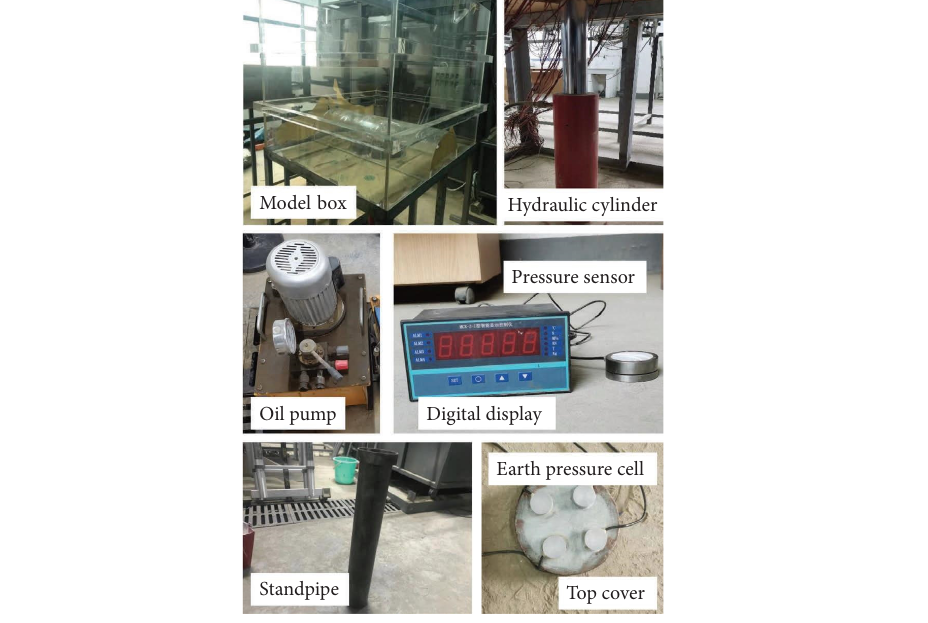
Figure 3: Test apparatus. Table 3: Basic physical properties of sand.